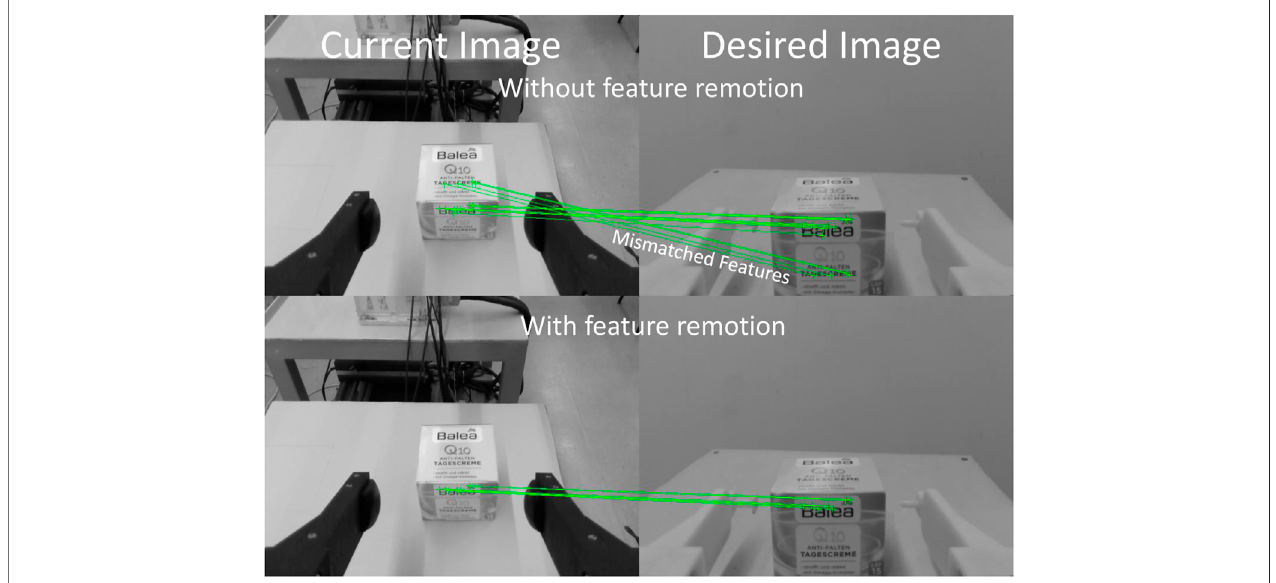
FIGURE2| Example ofmatched features without (top) and with (bottom) thefeature removing algorithm.Theimages ontheright showthe3Dprintedcalibration fi ngers mounted on the gripper grasping the object in the desired